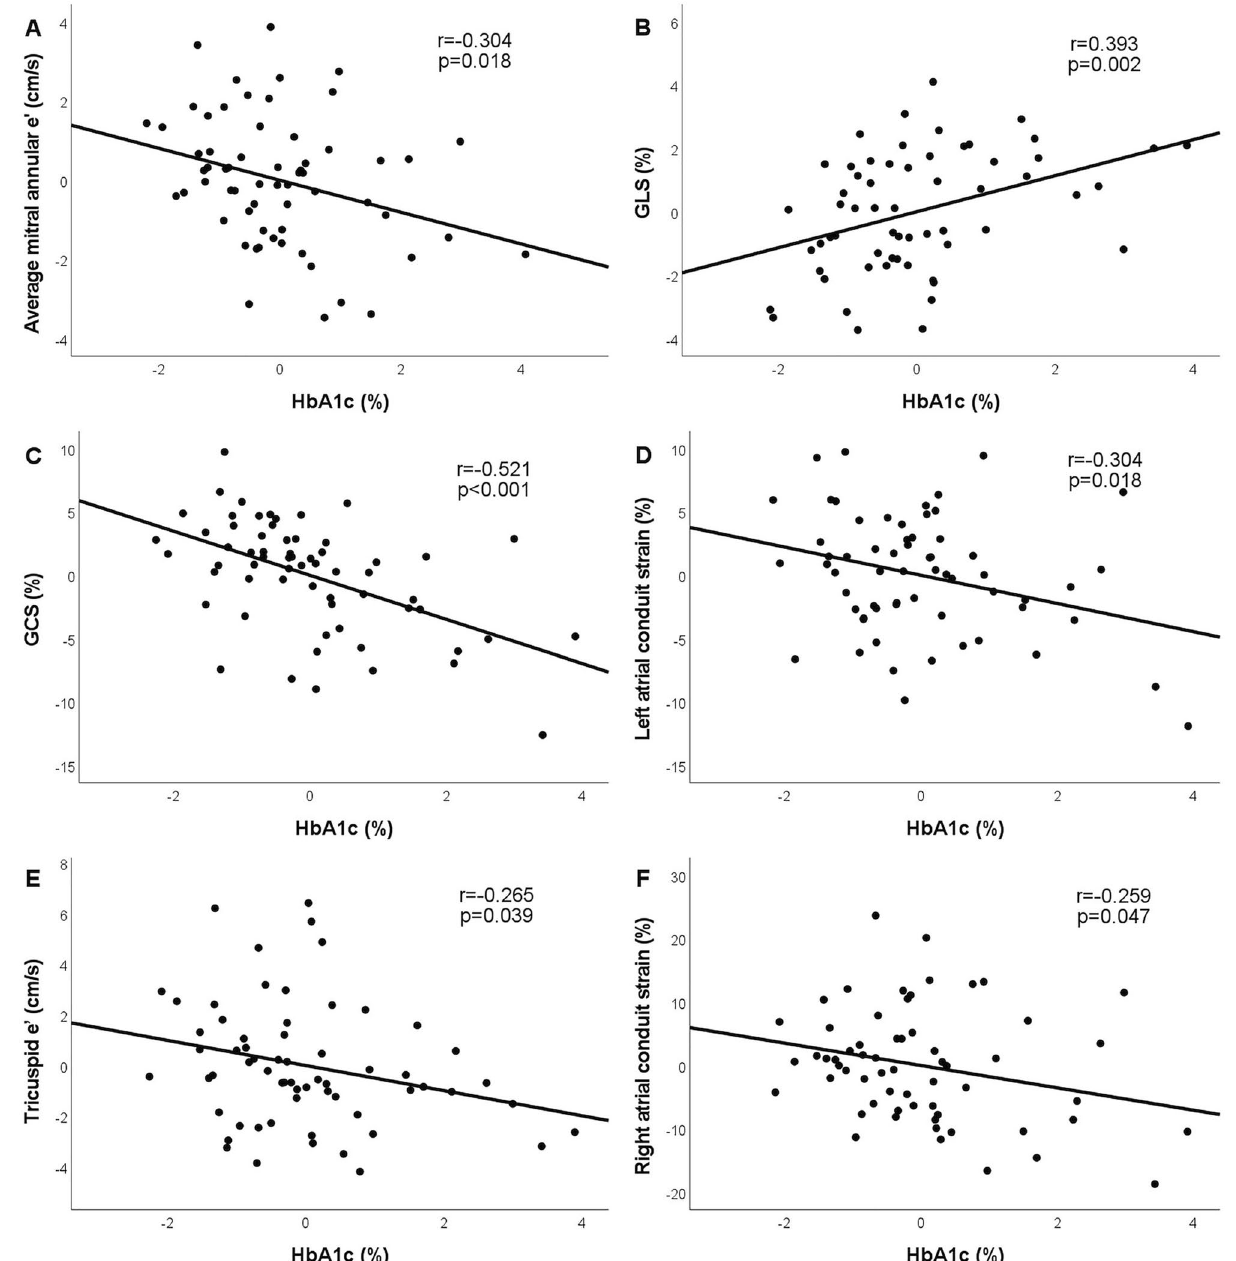
e ′ ( E ) and with RA conduit strain ( F ). Partial correlation coefficients are